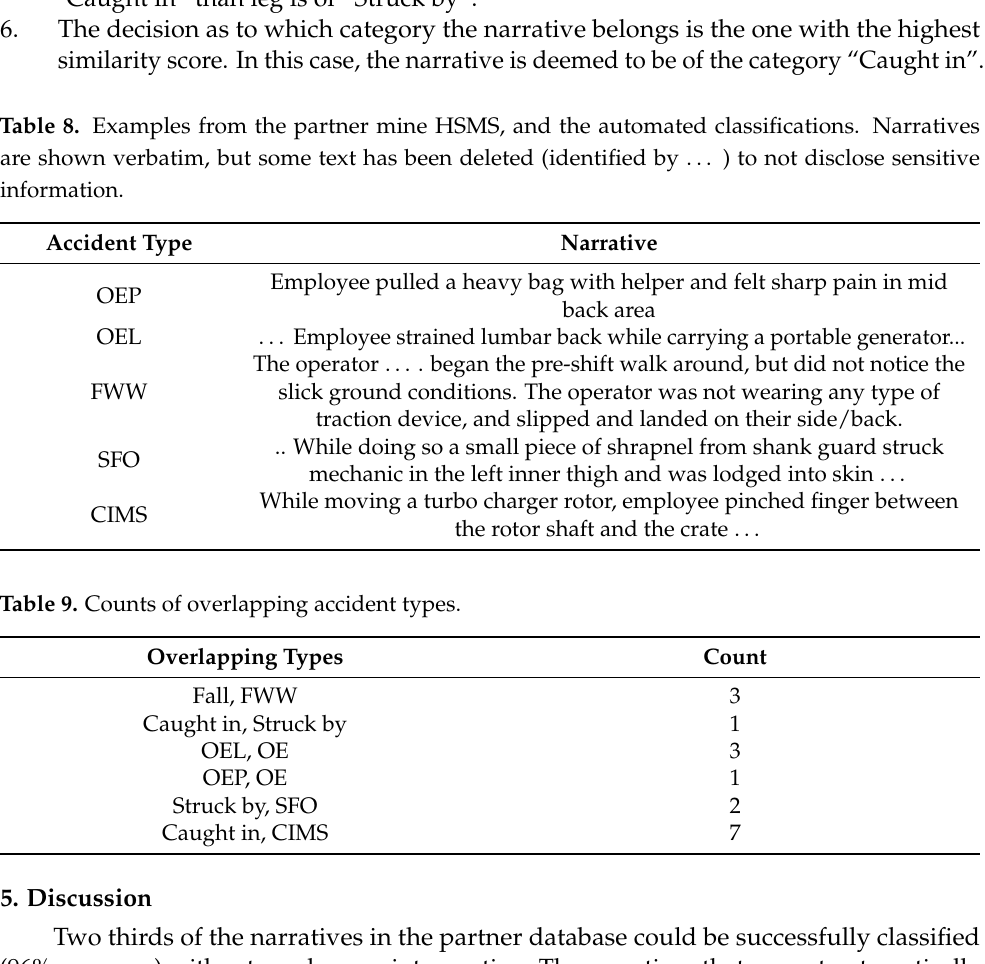
Table 8. Examples from the partner mine HSMS, and the automated classifications. Narratives are shown verbatim, but some text has been deleted (identified by . . . ) to not disclose sensitive information.